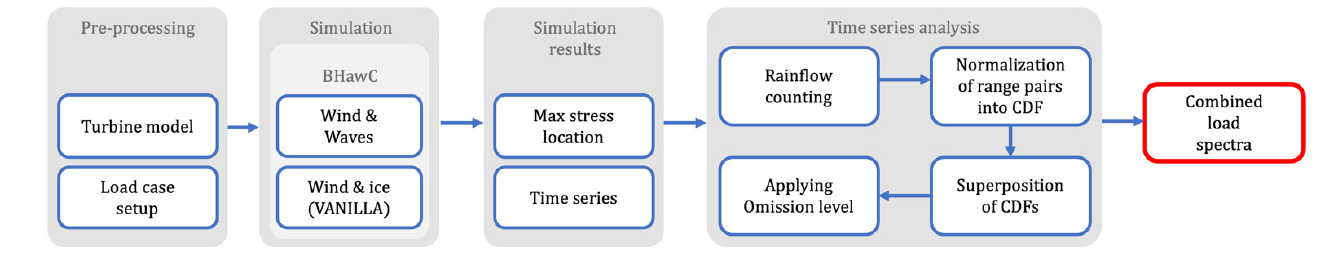
Figure 3. Flowchart of the data processing steps to develop combined load spectra from short-term stress-time series of structural response based on Milakovi ć et al. [5]